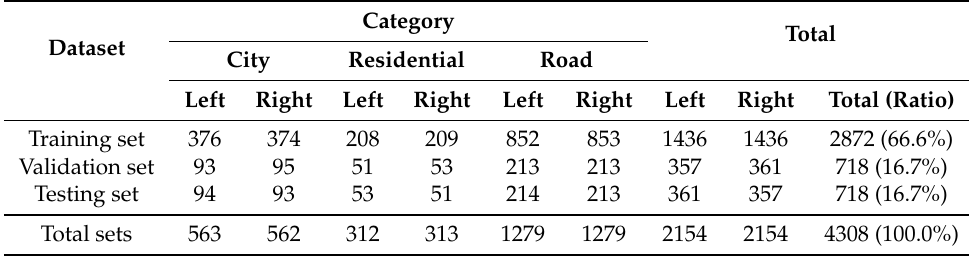
Table 1. Evaluation dataset.